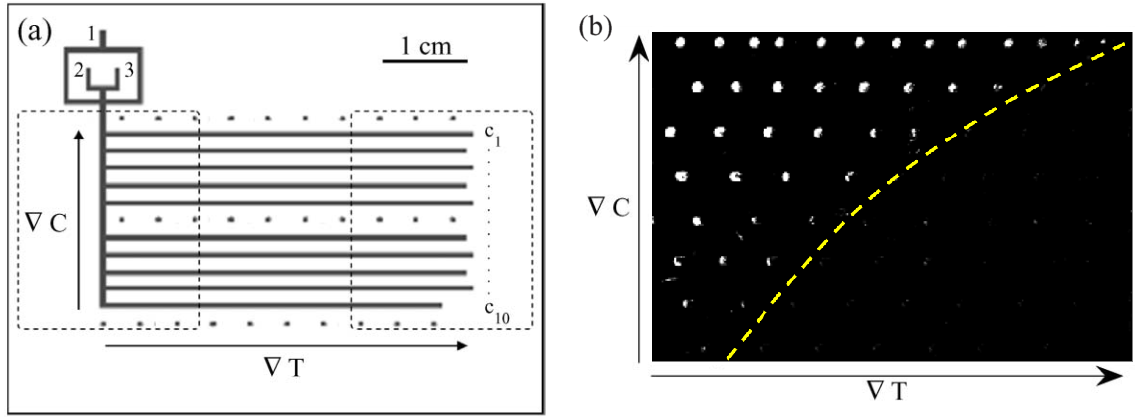
Figure 6. ( a ) Design of the microfluidic device (channel width 500microns). Silicone oil is injected in inlet 1 and aqueous solutions in inlets 2 and 3. The two dotted areas indicate the positions of Peltier modules used to apply temperature gradients. The three lines of dots mark the positions of temperature measurements. ( b ) Example of directly reading out of a solubility diagram. The dotted line surrounding droplets containing crystals gives an estimation of the solubility limit. Reprinted with permission from [35]. Copyright 2007, Royal Society of